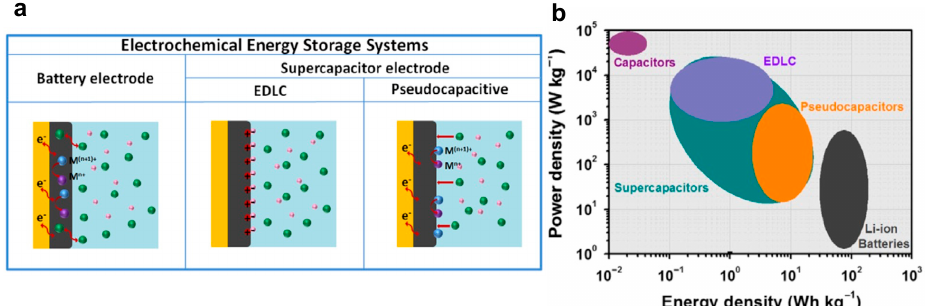
Figure 2. ( a ) Schematic of the energy storage mechanism of batteries and supercapacitors (EDLC and pseudocapacitors); ( b ) Ragone plot (specific power density against specific energy density) of energy storage devices. Reproduced with permission by [4].